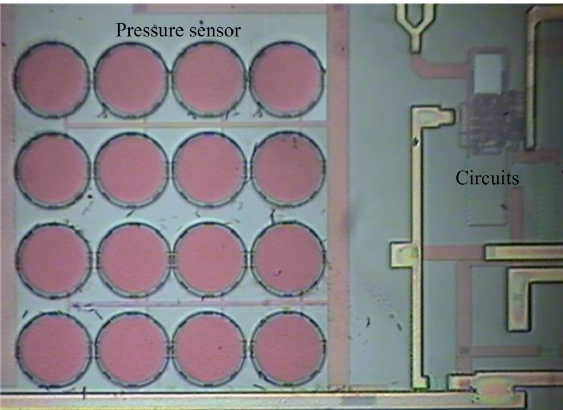
Figure 12. Photograph of the FET pressure sensor with circuits after the wet etching process.